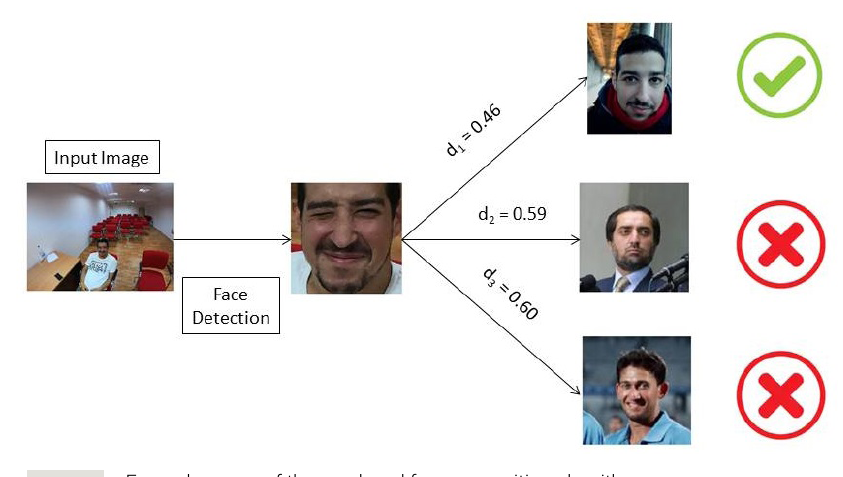
Example usage of the employed face-recognition algorithm.